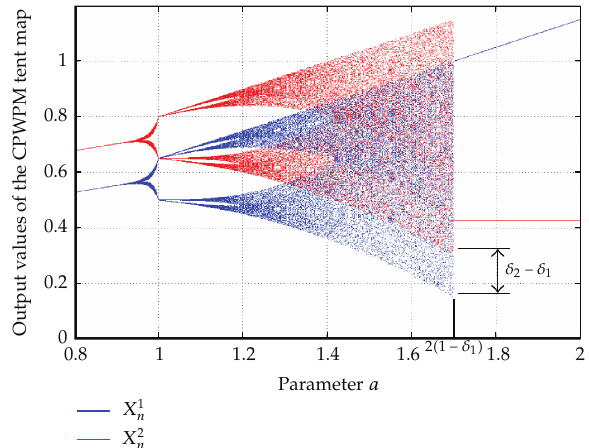
Figure 6: Bifurcation diagram of the CPWPM tent